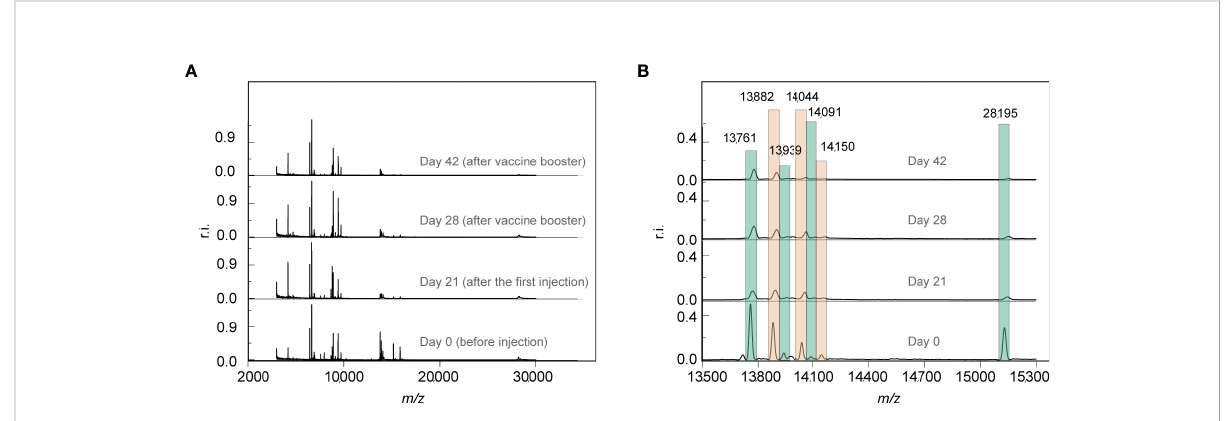
FIGURE 2 (A) The representative MALDI-TOF mass spectra of one participant at four time points pre-vaccination and post-vaccination. (B) Partial enlarged view of (A) . The mass spectra were normalized against the strongest peak. r.i.: relative